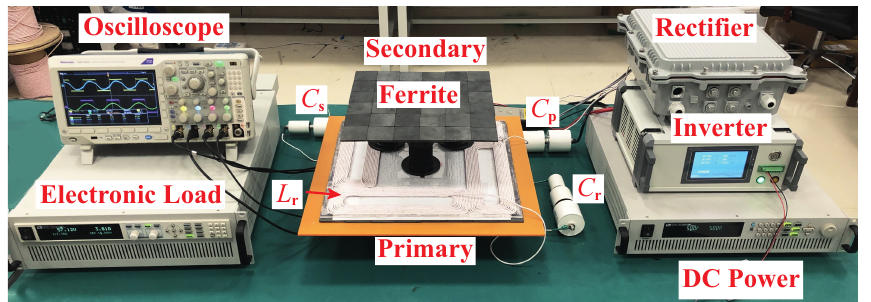
Figure 7. Experimental